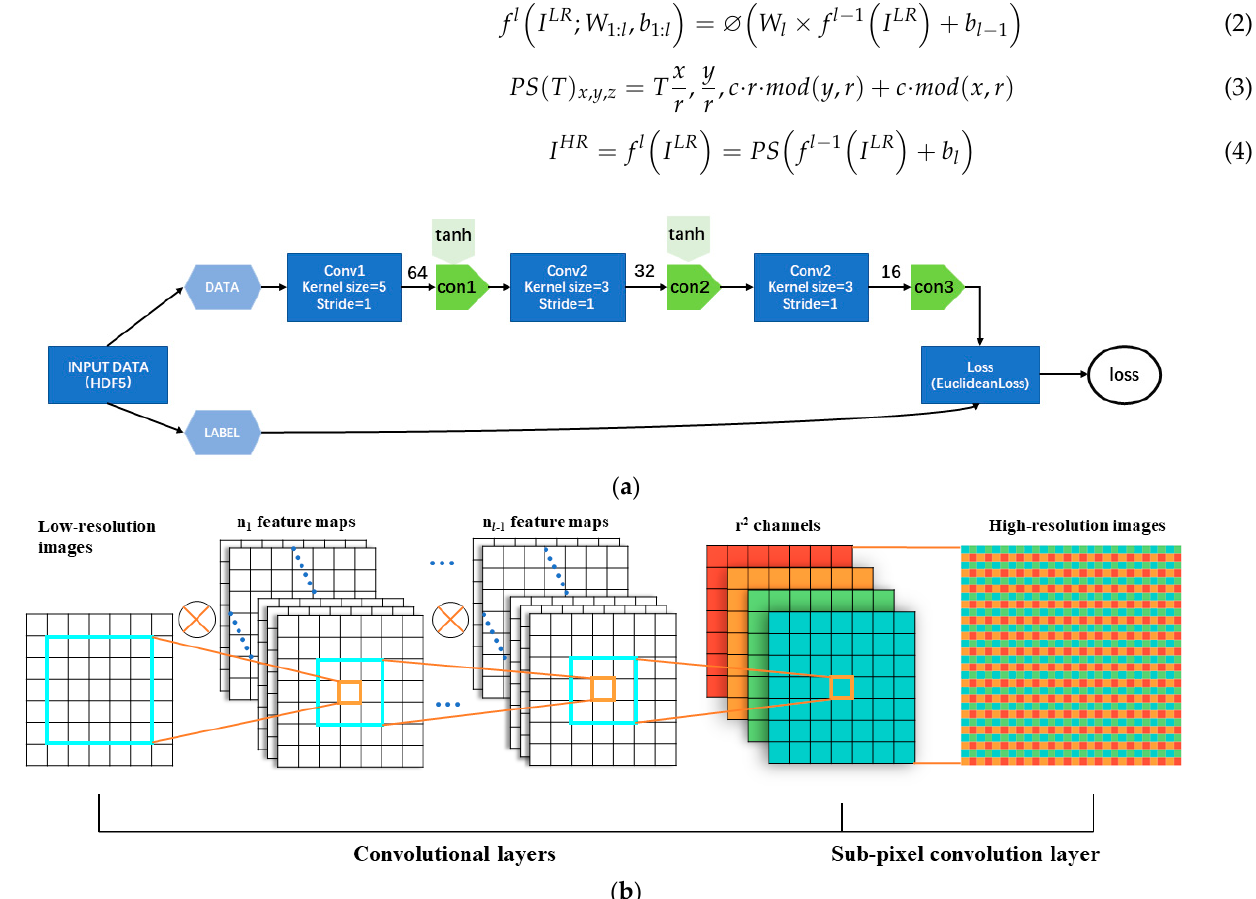
Figure 1. The framework of ESPCN: ( a ) the layers of the ESPCN used in our experiment; ( b ) the convolutional part and the sub-pixel convolution part of the network.